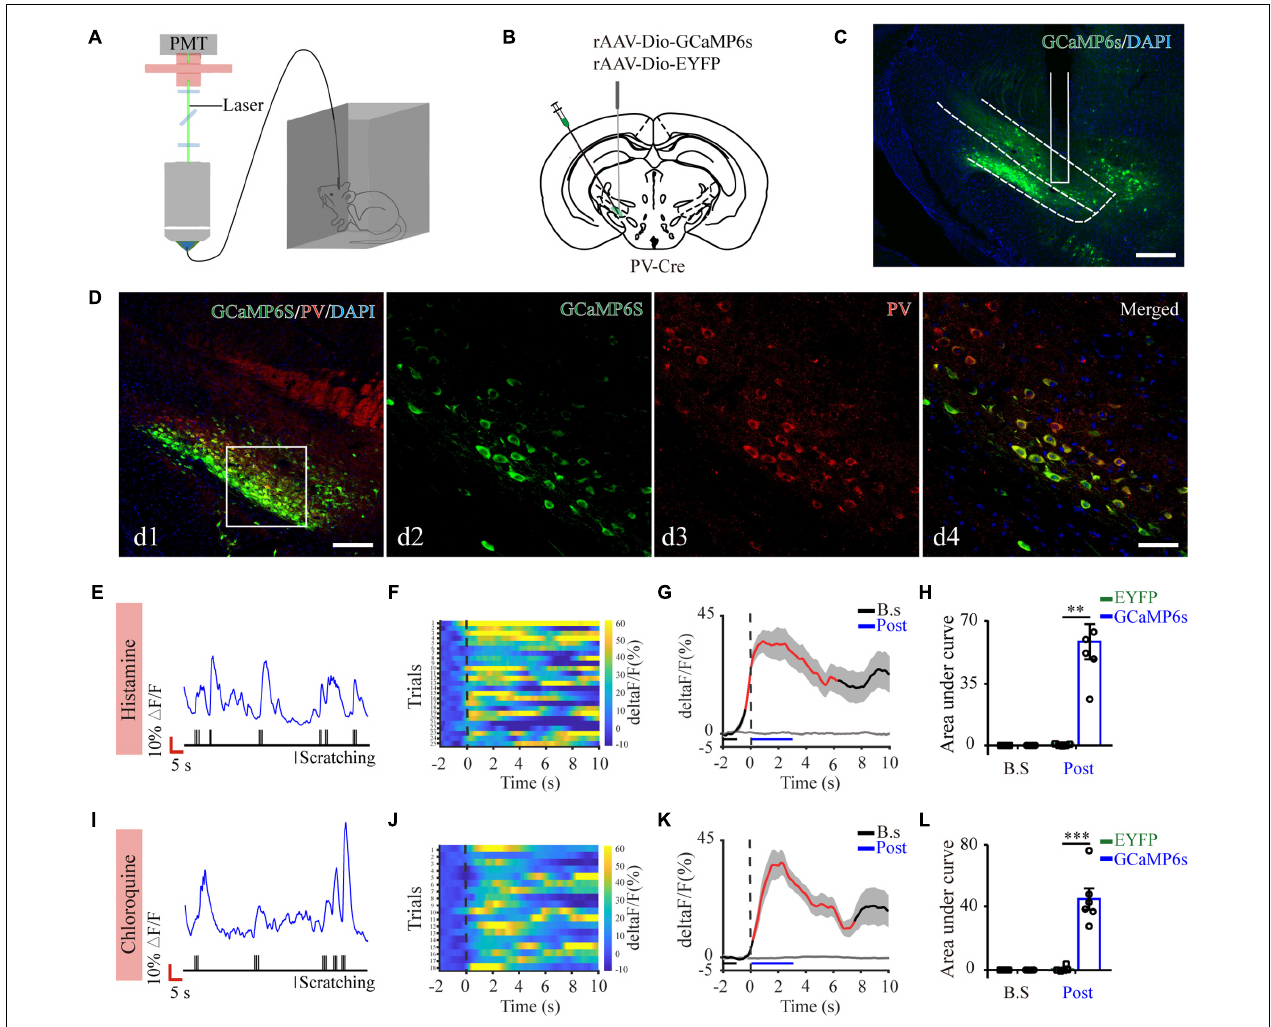
FIGURE 3 | Increased activity of ZI PV neurons during acute itch-induced scratching behavior. (A) The fiber photometry setup. (B) Schematic showing the viral targeting of AAV-DIO-GCaMP6s-EYFP and AAV-DIO-EYFP into the ZI of PV-Cre mice. (C) Histological verification of viral expression (green) and optical fiber implantation in the ZI in a representative mouse. (D) Representative photographs showing the expression of PV (red) in GCaMP6s-positive (green) neurons in the ZI of PV-Cre mice. The framed area in d1 was magnified in d2-4. Scale bars represent 100 µ m in d1 and 50 µ m in d2-4. (E) Representative GCaMP6s fluorescence trace (top) and behavioral trace (bottom) recorded simultaneously in ZI PV neurons in response to histamine injection. (F) Heatmap illustrating GCaMP6s fluorescence aligned to the beginning of individual scratching trains in all the mice in response to histamine stimuli. Each row represents Ca 2 + signals corresponding to one scratching train. The color scale at the right indicates (cid:49) F/F. (G) Mean fluorescent signal in response to histamine stimuli in all the mice recorded, with shaded areas indicating the SEM. The black and gray lines represent the signals of PV ZI neurons in mice with AAV-GCaMP6s and AAV-EYFP injection, respectively. The red line represents statistically significant increase from the baseline ( P < 0.05; multivariate permutation test). The vertical dotted line indicates the scratching bout. (H) Area under the curve showing fluorescence changes of ZI PV neurons in the mice with AAV-GCaMP6s and AAV-EYFP injection in both pre-scratching and post-scratching periods under the condition of histamine stimuli. Repeated ANOVA followed by simple effects analysis. n = 5 mice in EYFP group and 6 mice in GCaMP6s group, F (1,9) = 27.892, P = 0.001. (I–L) Same conventions as (E–H) but for recording in response to chloroquine stimuli. n = 5 mice in EYFP group and 6 mice in GCaMP6s group, F (1,9) = 36.586, P < 0.001. ∗∗∗ P < 0.001, ∗∗ P < 0.01. PMT,